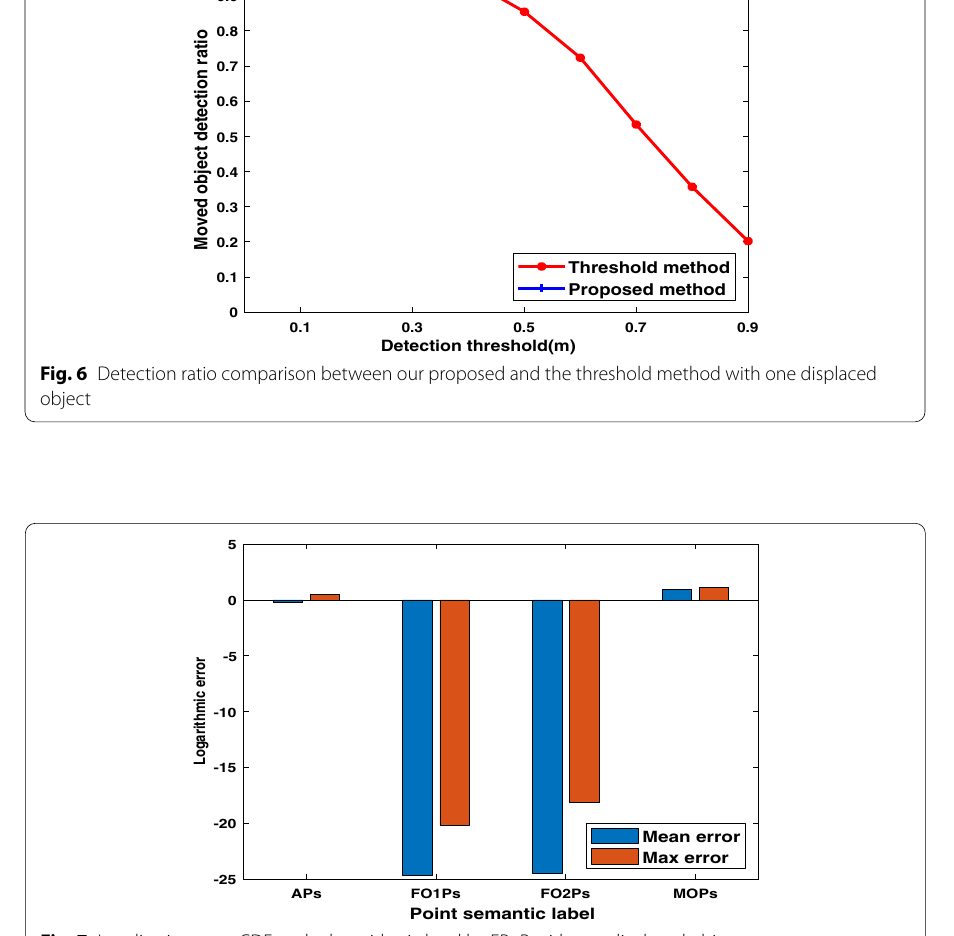
Fig. 7 Localization error CDF under logarithmic level by EPnP with one displaced object